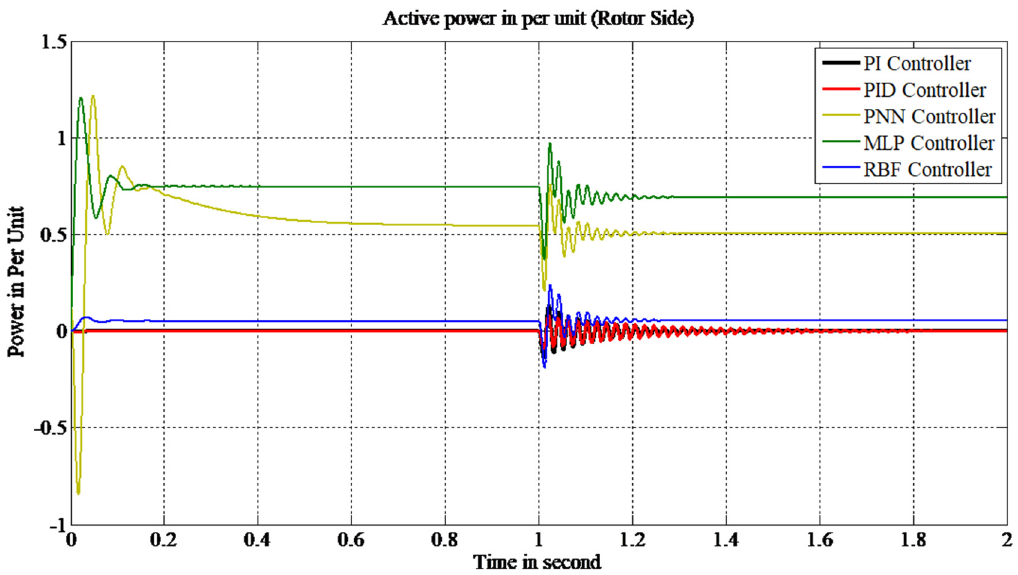
Figure 11. Active power at rotor.